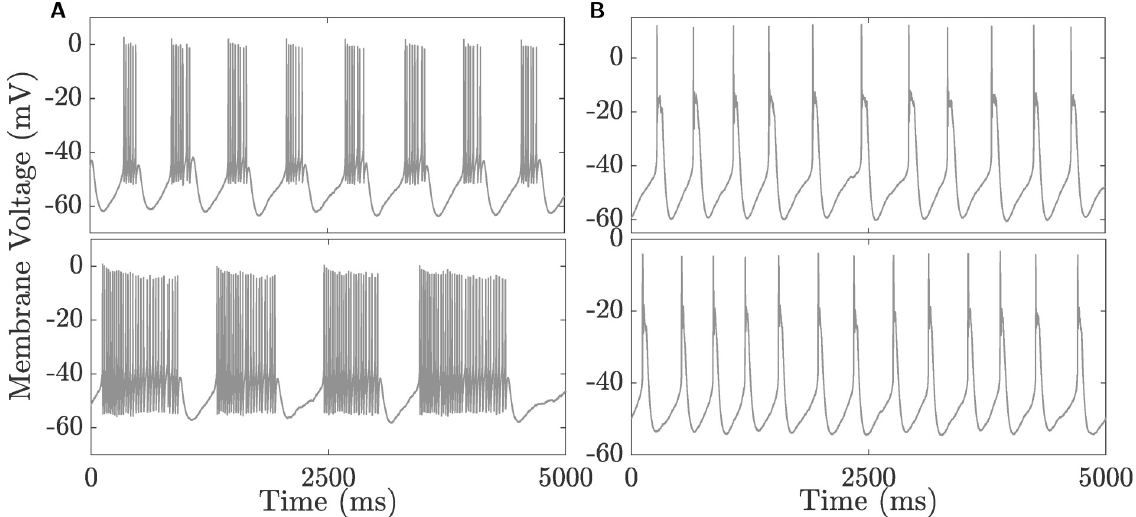
Fig 3. Two types of bursting recorded in CSCs. A ) Square-wave bursting recorded in two CSCs bathed in 2 mM 4-AP, exhibiting short (top) and long (bottom) active phases. B ) Pseudo-plateau bursting recorded in two CSCs bathed in 2 mM 4-AP and 300 μ M Cd 2+ , both exhibiting similar